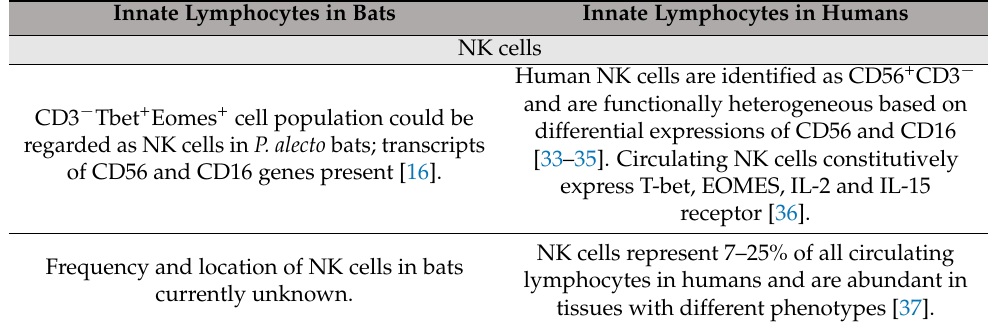
Table 1. Brief summary of known characteristics of innate lymphocytes in humans and